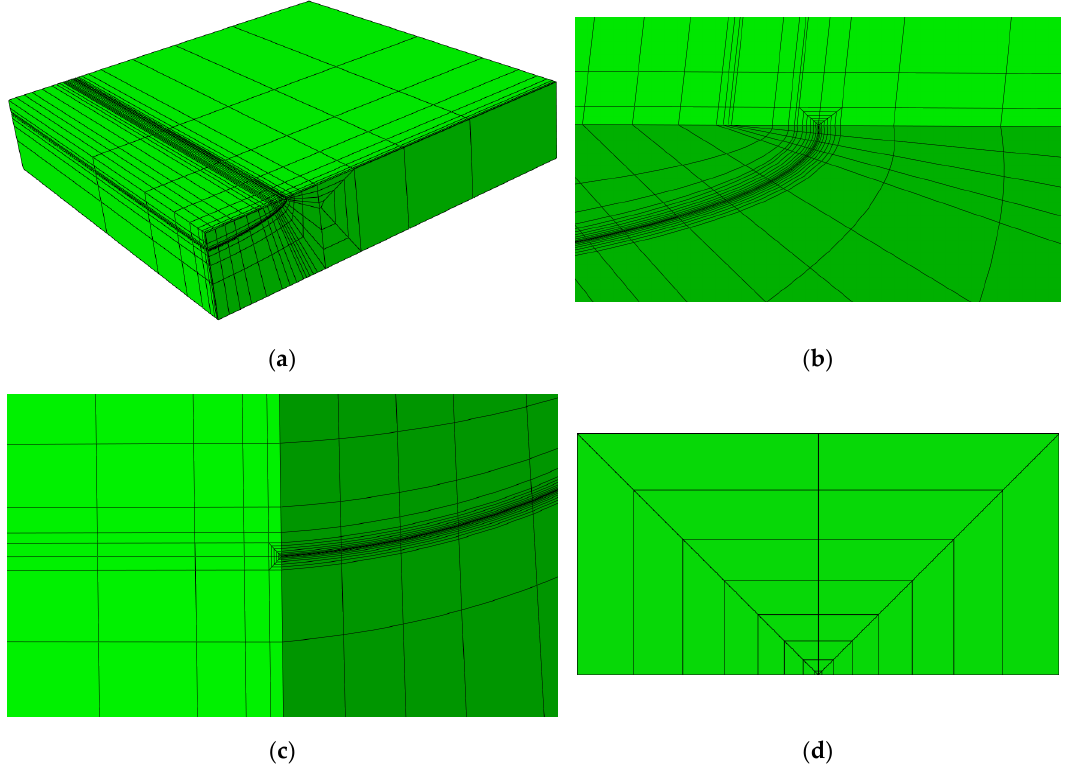
Figure 2. Typical FE mesh of FG plate with semi-elliptical surface crack, a / c = 0.2, a / t = 0.2. ( a ) FE mesh of the entire cracked FG plate; ( b ) FE mesh near the surface point; ( c ) FE mesh near the deepest point; ( d ) FE mesh of the near-tip region.